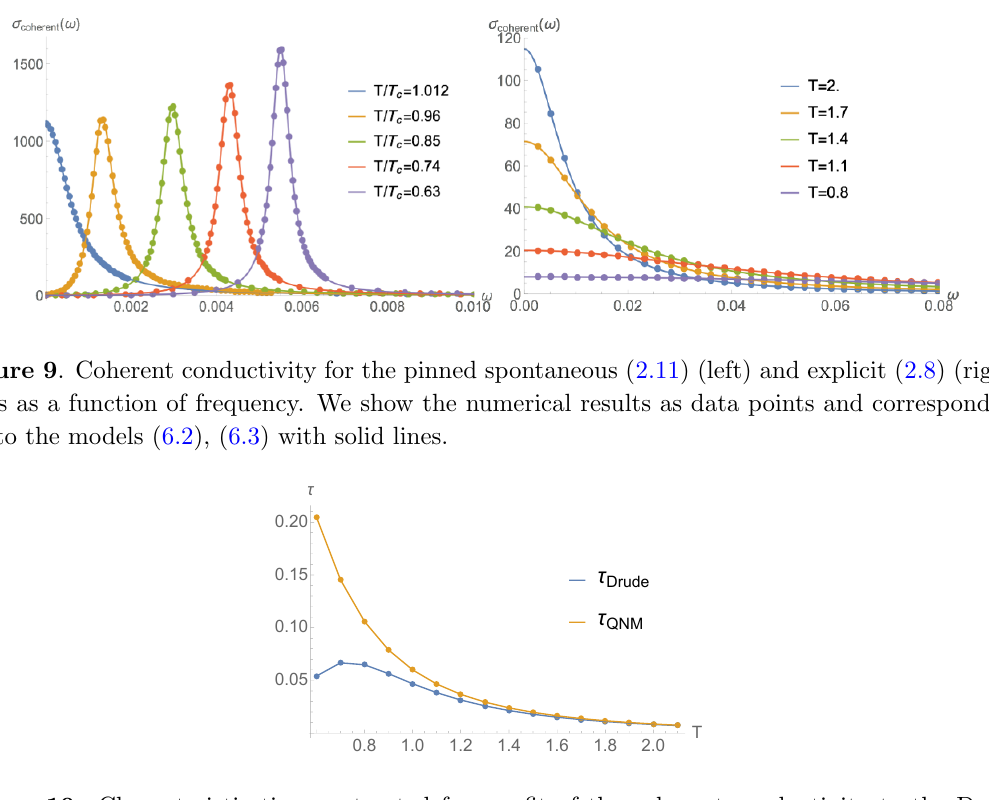
Figure 10 . Characteristic times extracted from a (cid:12)t of the coherent conductivity to the Drude formula (6.2) (blue), and from the imaginary part of the lowest lying QNM (yellow), as a function of temperature for the explicit insulator